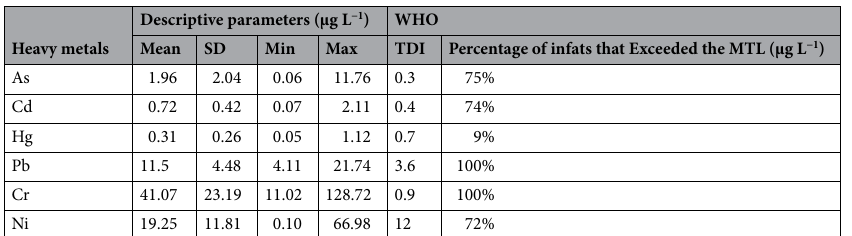
Table 1. The heavy metals concentration of breast milk. TDI tolerable daily intake, MTL maximum tolerable limit.